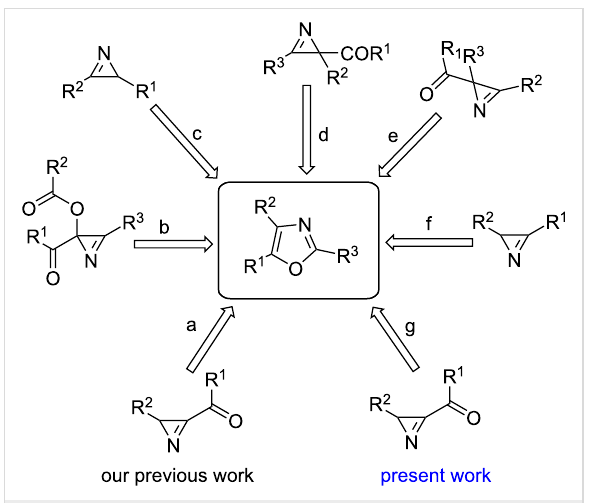
Scheme 1: Strategies for the synthesis of 2,4,5-trisubstituted oxazole from azirine. a) I 2 , PPh 3 ; b) NaH, 1 H -pyrazole; c) 2-bromoacetyl bromide, NaN 3 ; d) heating; e) t -BuOK; f) Ph-CHO, visible light; g) KSCN, K 2 S 2 O 8